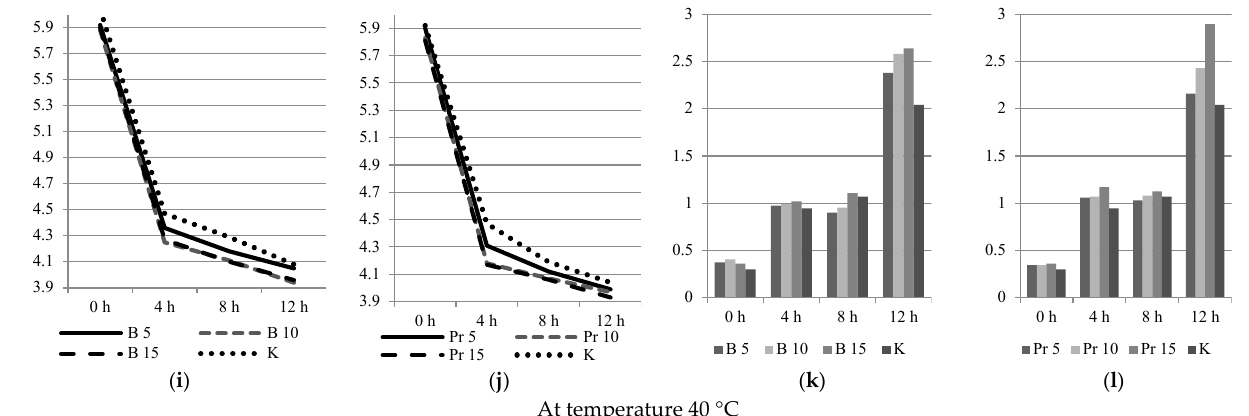
Figure 4. Dynamics of the acidity of hen gizzards during the hydrolysis period—at temperature 30 °C: ( a ) рН level, when treated with BLC; ( b ) рН level, when treated with Propionix LCSC; ( c ) titrated acidity, when treated with BLC; ( d ) titrated acidity, when treated with Propionix LCSC; at temperature 35 °C: ( e ) рН level, when treated with BLC; ( f ) рН level, when treated with Propionix LCSC; ( g ) titrated acidity, when treated with BLC; ( h ) titrated acidity, when treated with Propionix LCSC; at temperature 40 °C: (i) рН level, when treated with BLC; ( j ) рН level, when treated with Propionix LCSC; ( k ) titrated acidity, when treated with BLC; ( l ) titrated acidity, when treated with Propionix LCSC.